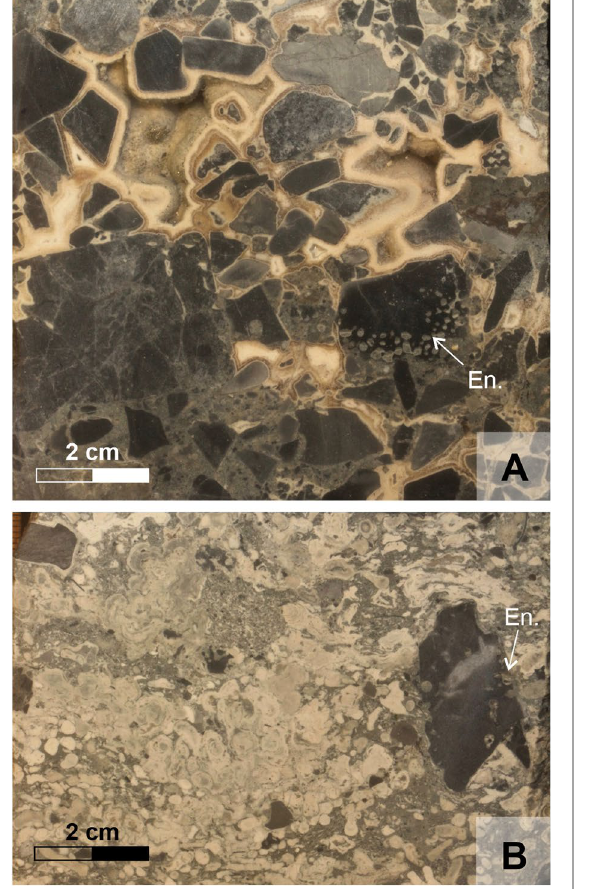
Fig. 6 A Polished core surface of the transgression conglomerate of Triassic dolomite clasts lithified by several cement generations. Some of the components are bored by Entobia igen. (En.), the brownish/ reddish coloration stems from pyrite crystals (sample HA 518/16). B Limestone sample immediately above the Triassic basement with bored ( Entobia igen., En.) dolomite clasts, coralline algal encrusted clasts and rhodolites and branch fragments of coralline algae (polished core surface, sample HA 540/15)